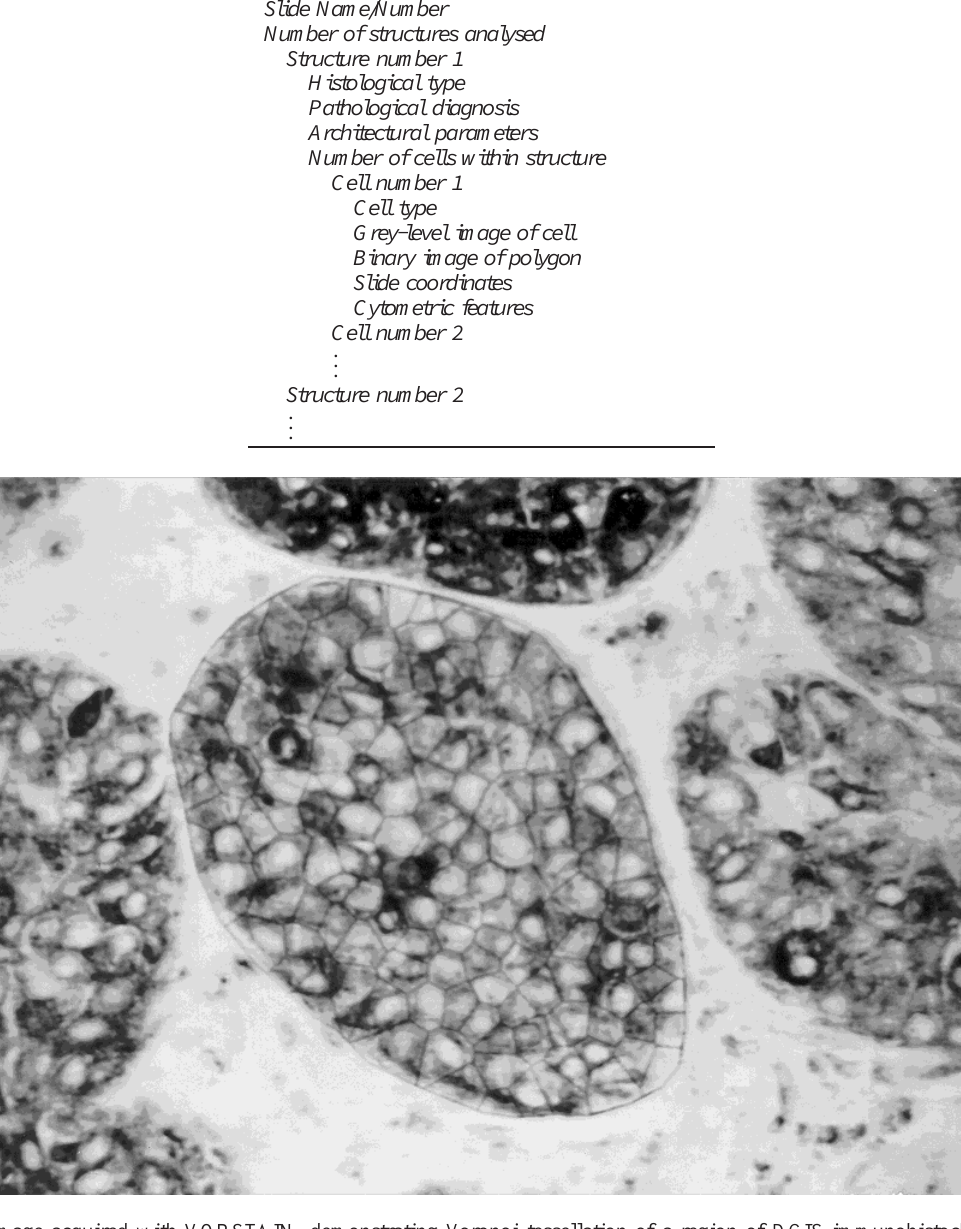
Fig. 4. Image acquired with VORSTAIN, demonstrating Voronoi tessellation of a region of DCIS immunohistochemically labelled for bcl -2